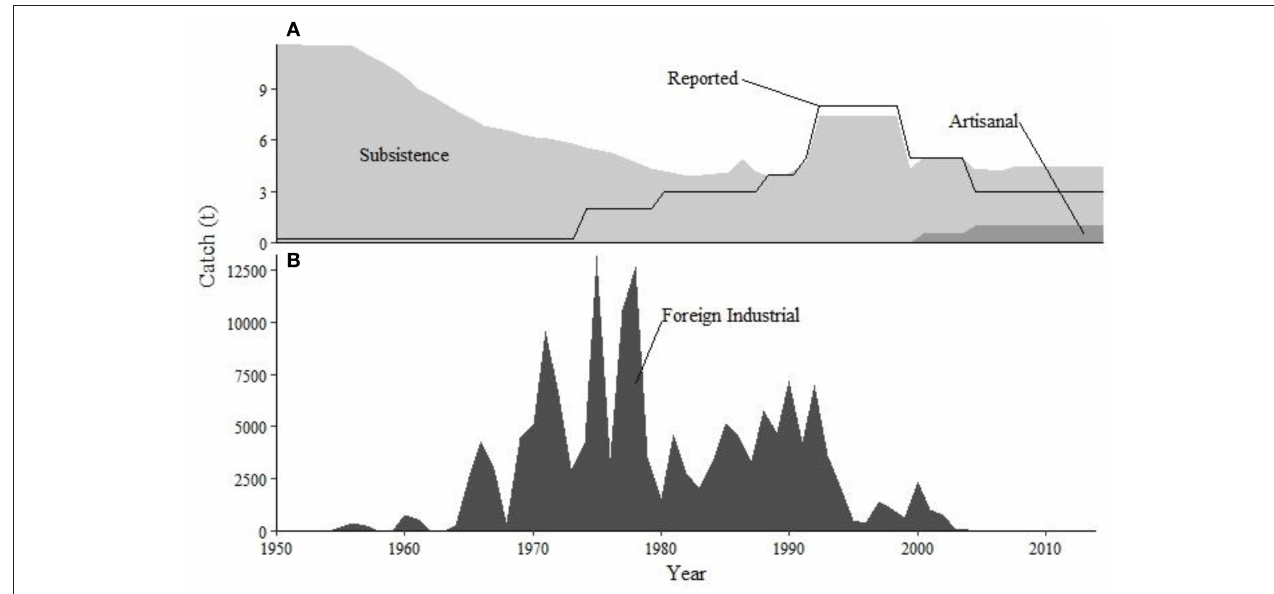
FIGURE 2 | Reconstructed catch (tons) for the Pitcairn Islands Exclusive Economic Zone (EEZ) for 1950–2014, (A) Reconstructed domestic catch by sector, with the domestic catch reported to FAO superimposed as a black line; and (B) Reconstructed foreign industrial